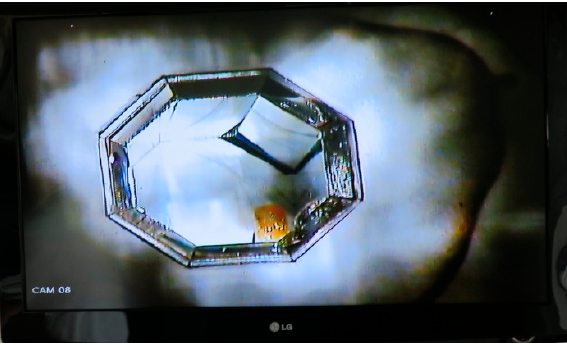
Figure 10. Damaged 8-side homogeniser, while being submitted to an estimated total power of 24.7 kW.